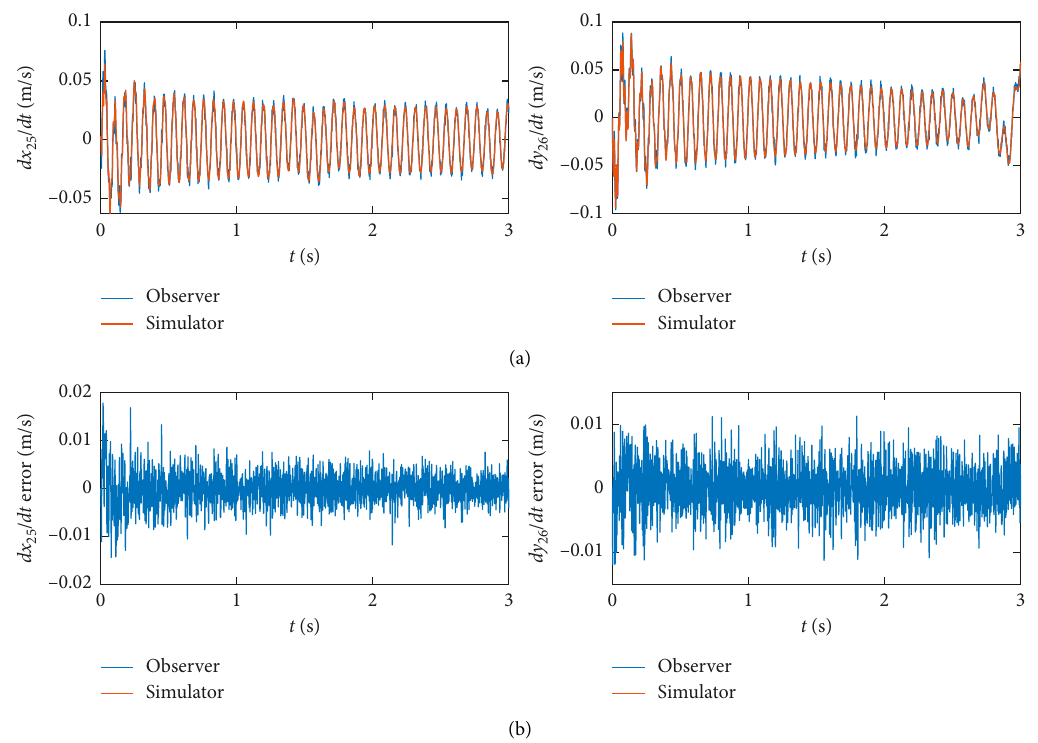
Figure 9: Estimated elastic velocities of the elastic coordinates of the end-effector (a) and estimation error (b).